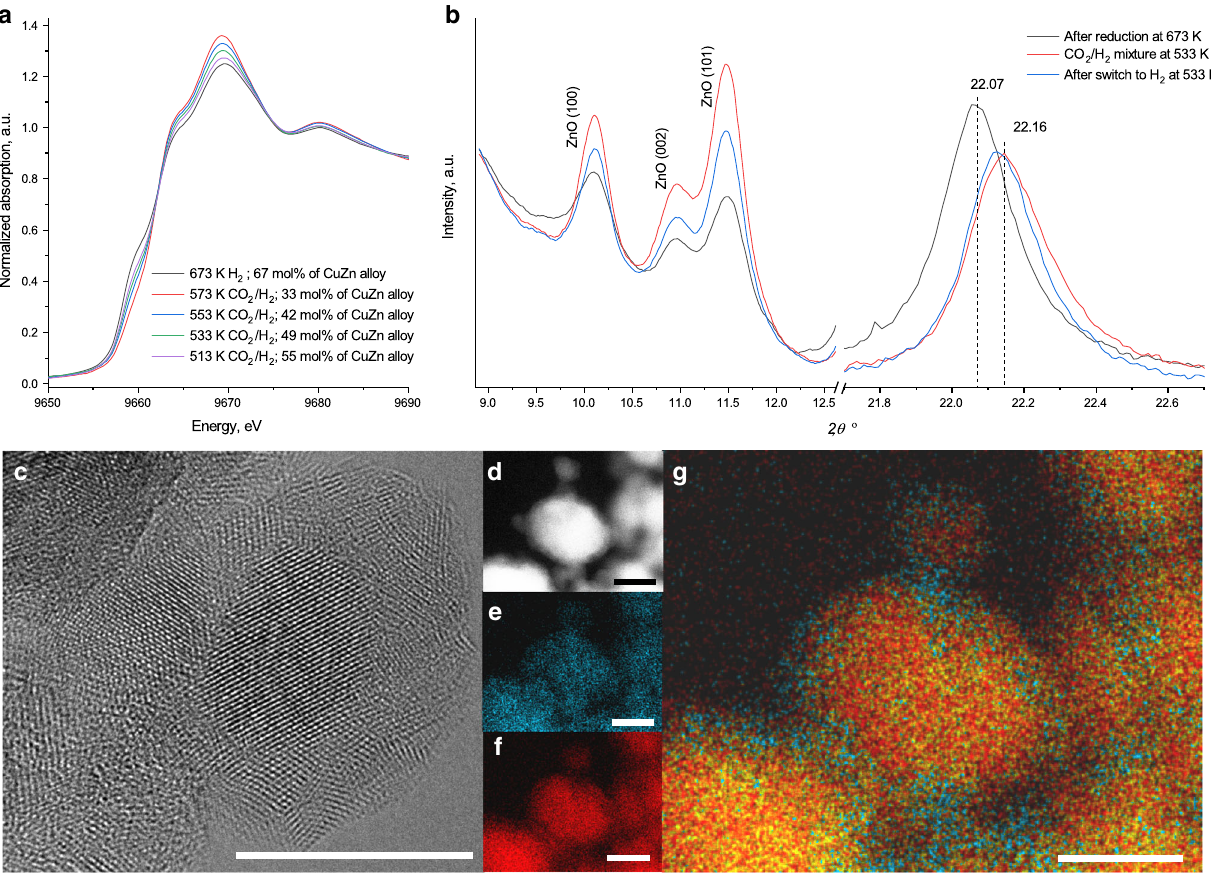
Fig. 3 De-alloying of copper – zinc phase under reaction conditions. a Zn K-edge XANES spectrum of pretreated at 673 K and 15 bar of hydrogen CZA catalysts as well as spectra of this pretreated material after switch to CO 2 /H 2 at different reaction temperatures: 573, 553, 533, and 513 K. b Operando XRD patterns ( λ = 0.4975 A) of CZA catalyst pretreated at 673 K and 15 bar in hydrogen and after switching to CO 2 /H 2 reaction mixture or back to hydrogen at 533 K. c HRTEM micrograph, d HAADF-STEM image, EDX mapping of zinc ( e ), copper ( f ), as well as overlay ( g ) after CZA catalyst pretreatment at 673 K and 15 bar in hydrogen and switching to CO 2 /H 2 reaction mixture at 533 K and reaction for 3 h (scale bar — 10